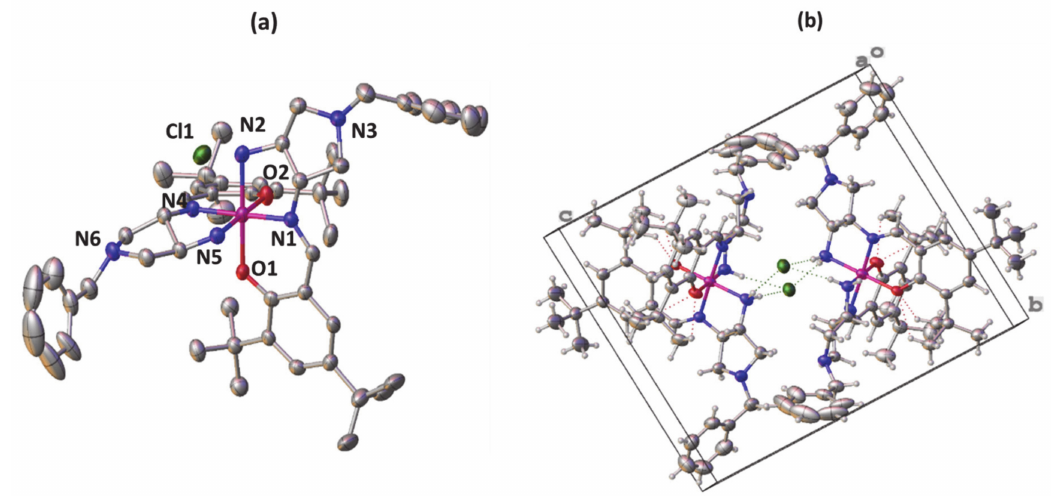
Figure 2. X-ray structure of the cobalt(III) complexes 2 : ( a ) ∆ ( S , S )- 2 (hydrogen atoms are omitted for clarity); ( b ) The com- Catalysts 2021 , 11 , x FOR PEER REVIEW plexes Λ ( R , R )- 2 and ∆ ( S , S )- 2 in the unit cell.